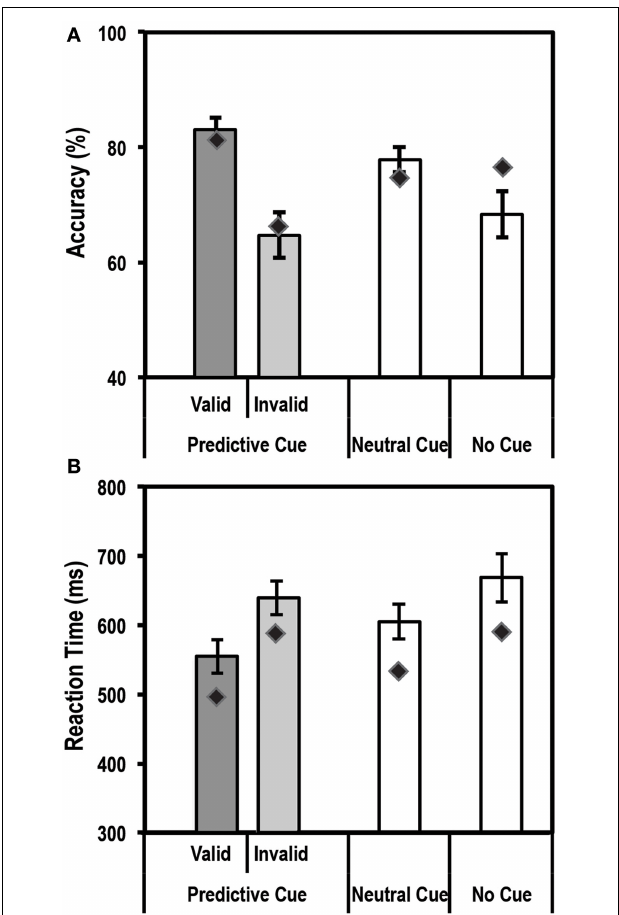
FIGURE 3 | Average accuracy (A) and reaction time (RT) data (B) for age-matched controls ( N = 10) and the patient for the Endogenous Cueing Task. Dark gray bars represent performance on validly cued trials. Light gray bars represent performance on invalidly cued trials. Unshaded bars show performance on Neutral and No-Cue trials. Error bars represent standard error of the mean for the control group. Diamond markers indicate performance of the patient. The patient and control group showed similar facilitation effects in accuracy and RT (i.e., faster and more accurate on valid relative to invalid trials).